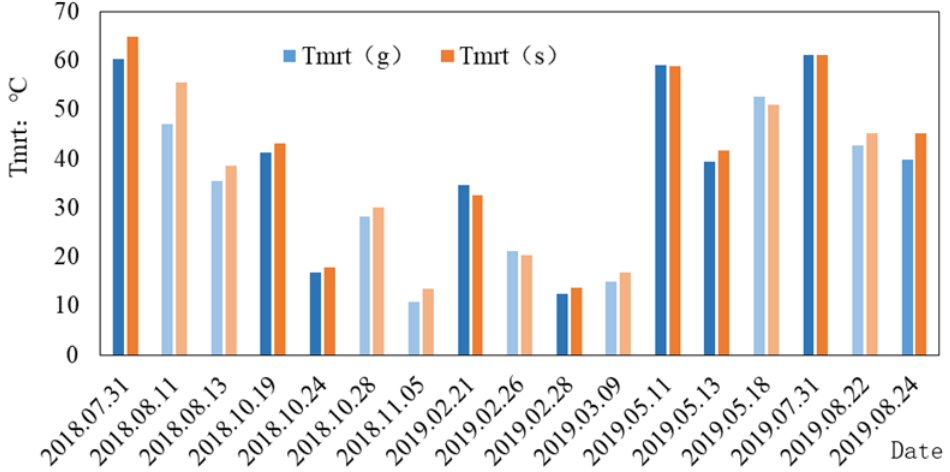
Figure 4. Average Tmrt results calculated by six-direction radiation method and globe-thermometer method.